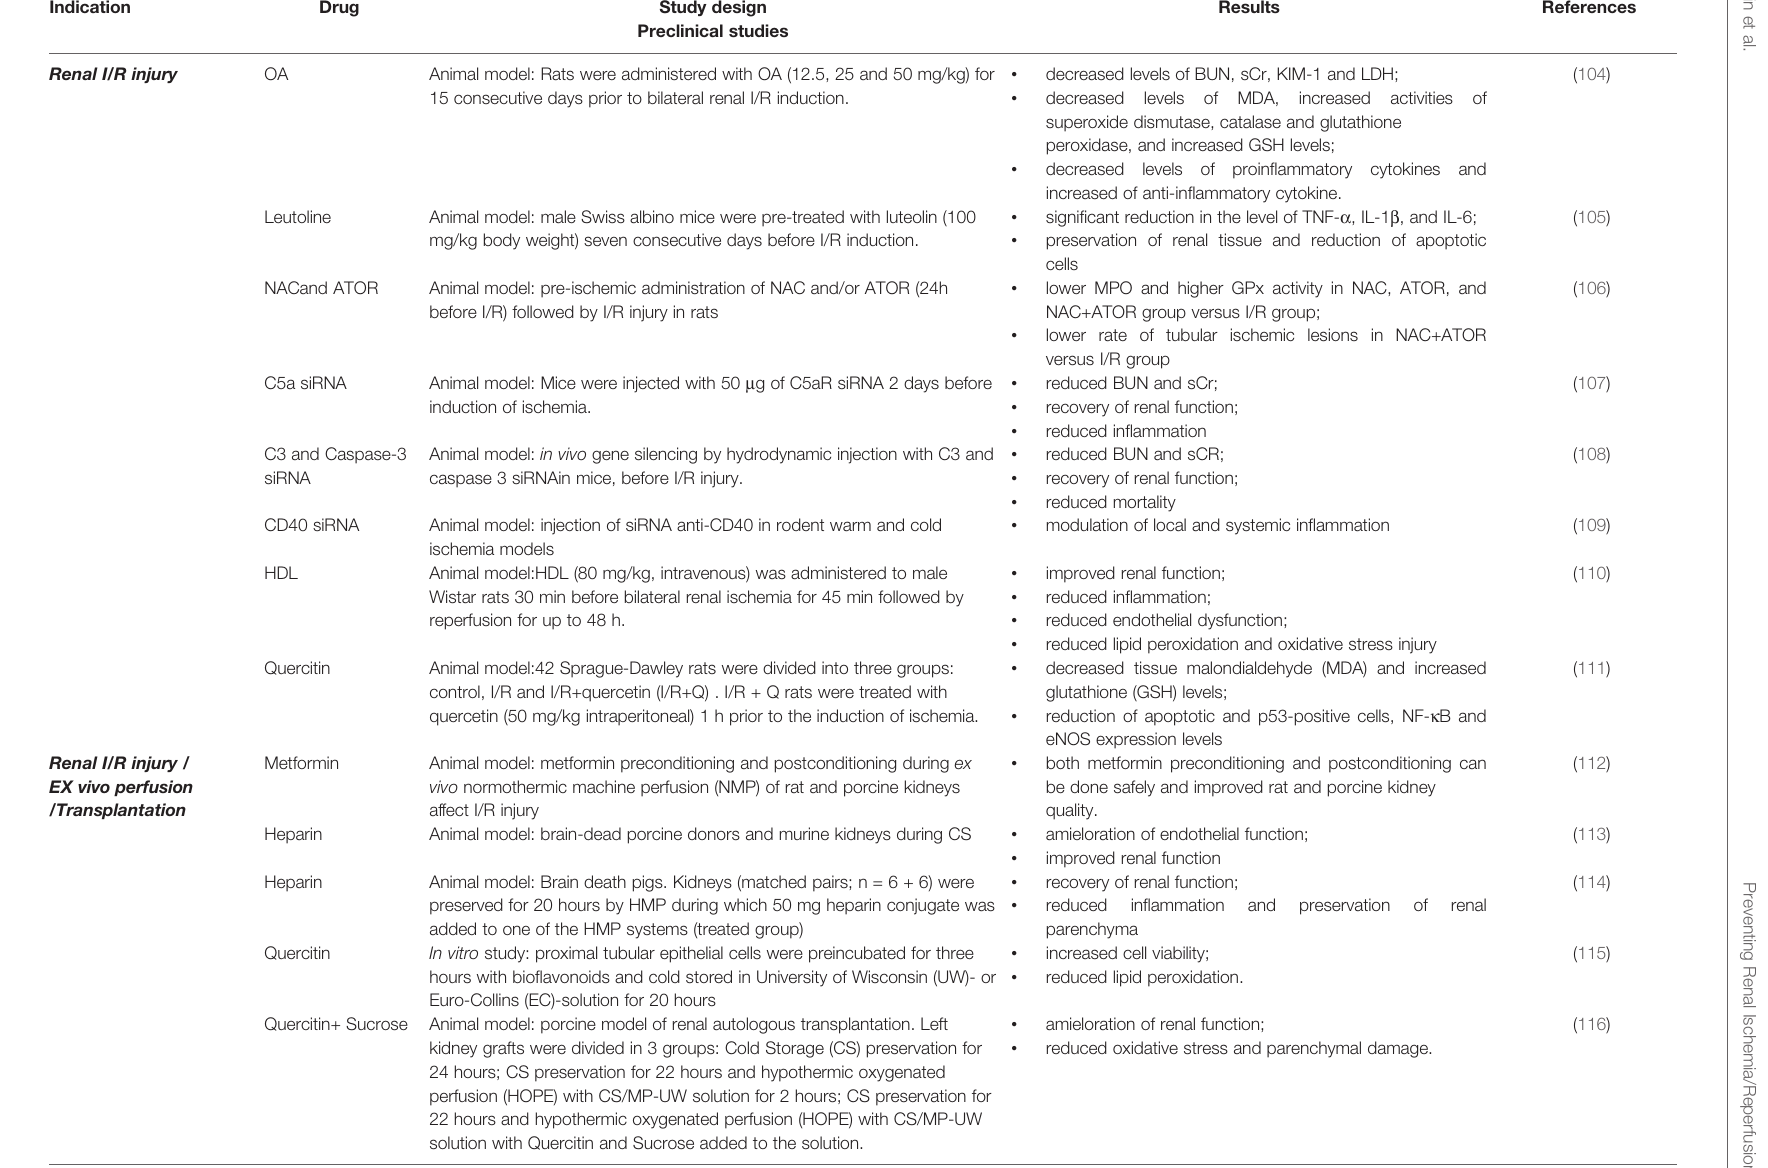
TABLE 1 | Pharmacological treatment in transplantation fi eld to prevent IR injury. Indication Drug Study